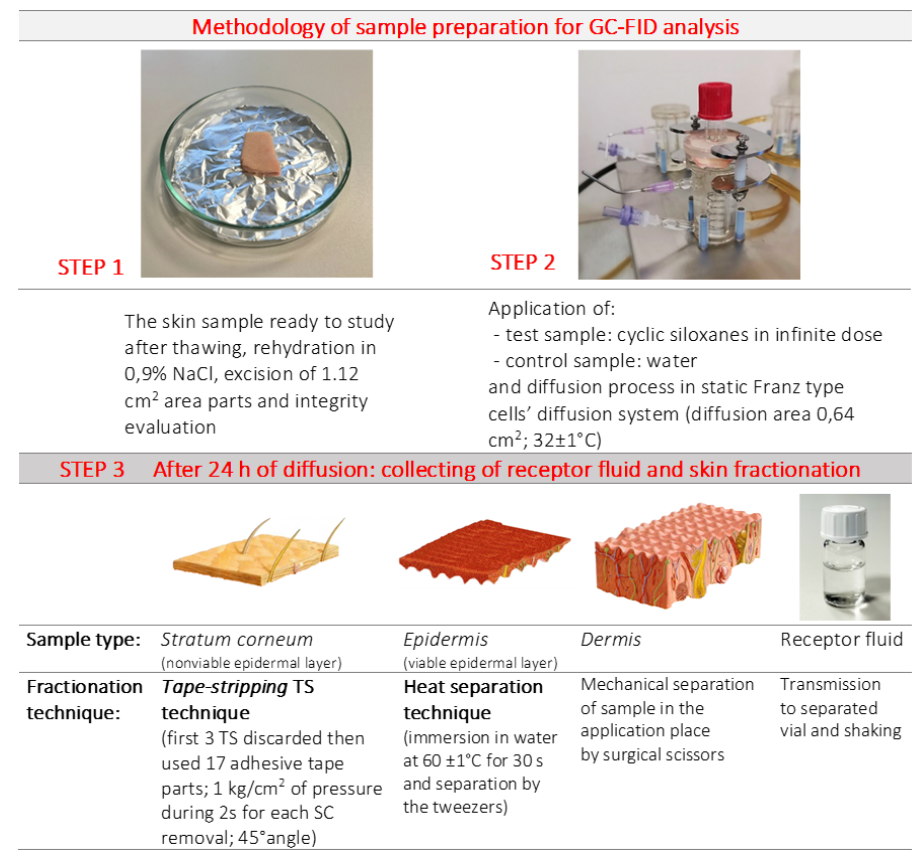
Figure 1. The methodology of sample preparation for gas chromatography-flame ionization detector (GC-FID) analysis. (GC-FID)